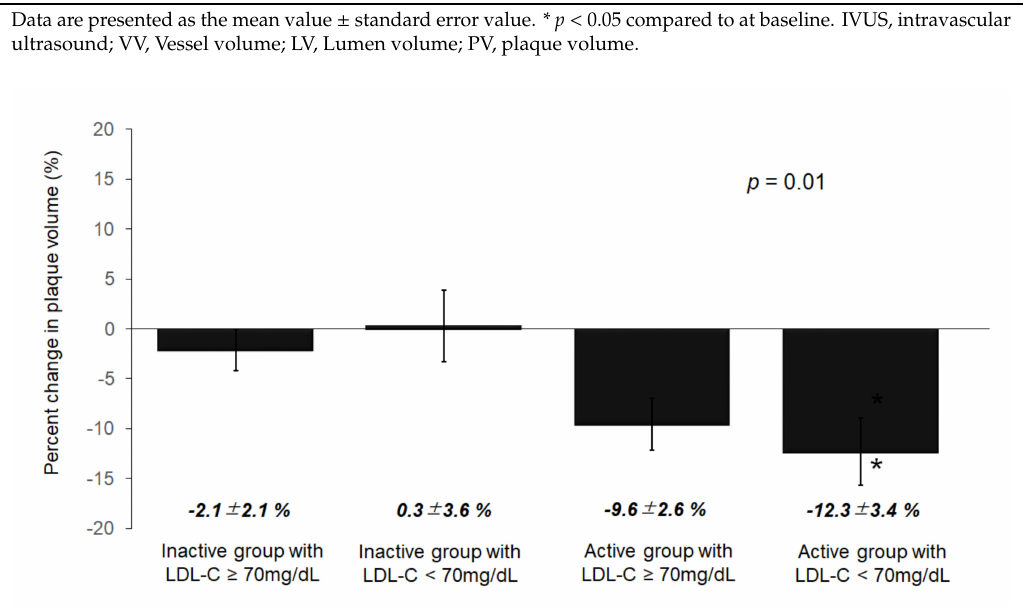
Figure 4. Percent change in the plaque volume among the four groups. The percent change in PV significantly di ff ered among the 4 groups (group 1; − 2.1 ± 2.1 vs. group 2; 0.3 ± 3.6 vs. group 3; − 9.6 ± 2.6 vs. group 4; − 12.3 ± 3.4%, p = 0.01). In particular, the percent change in PV in group 4 was significantly reduced (* p = 0.03 compared among 4 groups using Dunnett test). PV, plaque